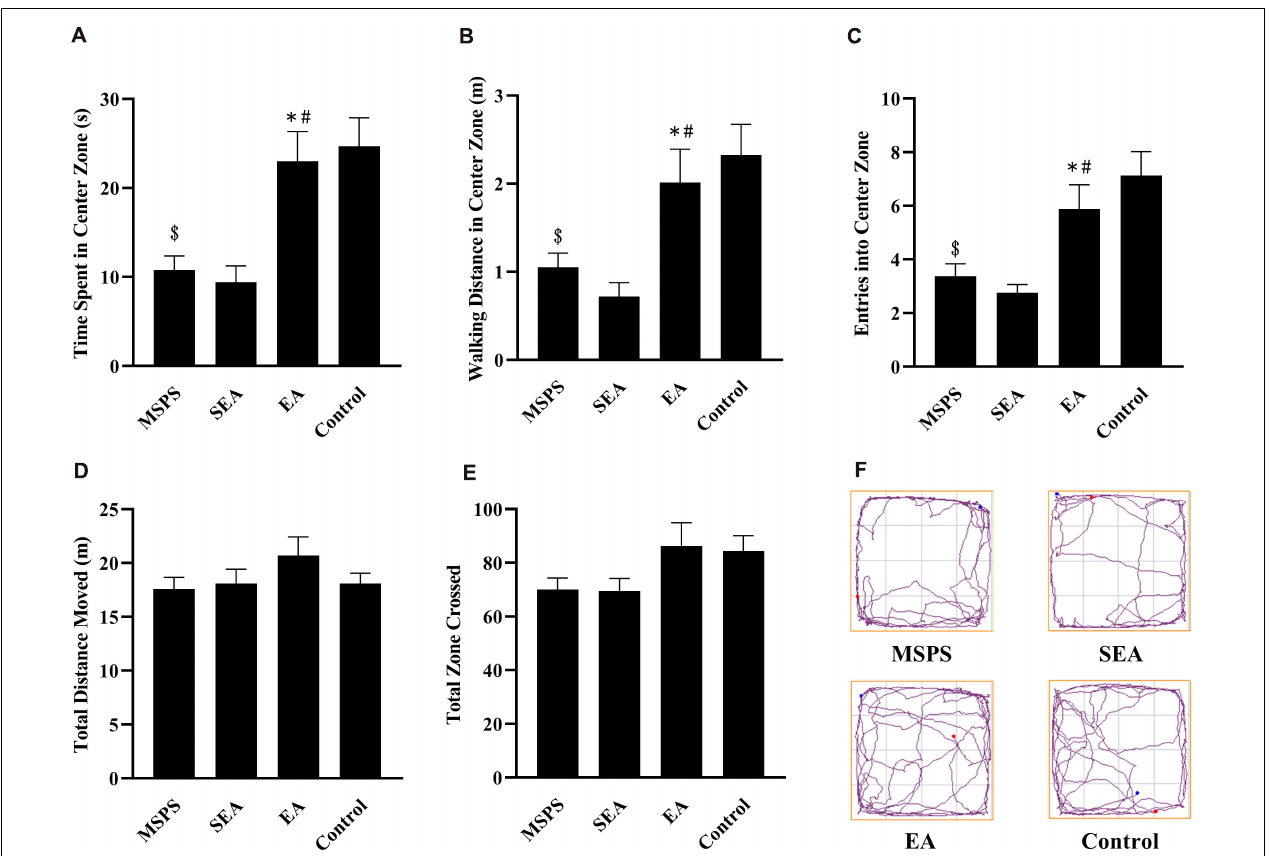
FIGURE 1 | EA at ST36 alters MSPS model rat anxiety-like behaviors in OFT experiments. (A) Time spent in the central region in seconds. (B) Distance traveled in the central region (m). (C) Central region entries. (D) Total distance moved (m). (E) Total zone crossings. (F) Representative tracking plots. Data are means ±